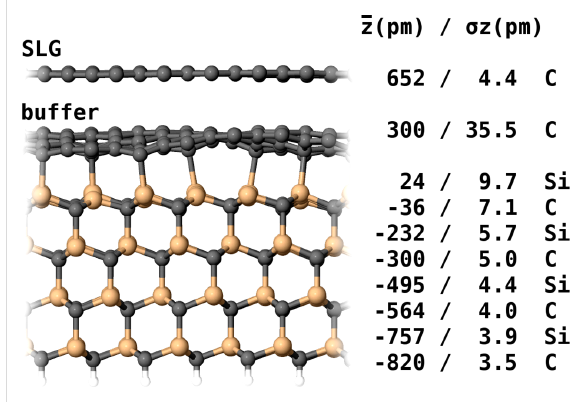
Figure 4: The fully relaxed theoretical model of SLG on the buffer layer, that is using the 6 × 6 unit cell. The z values in the table correspond to z-positions of C and Si atomic layers in the model, σ z is a standard deviation of atom positions. The standard deviation of the C atom z-positions in the SLG layer is 4.4 pm.